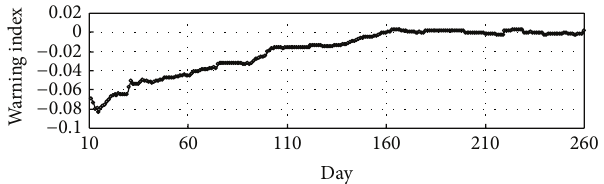
Figure 7: Training effect of warning idex for train running safety using PCA